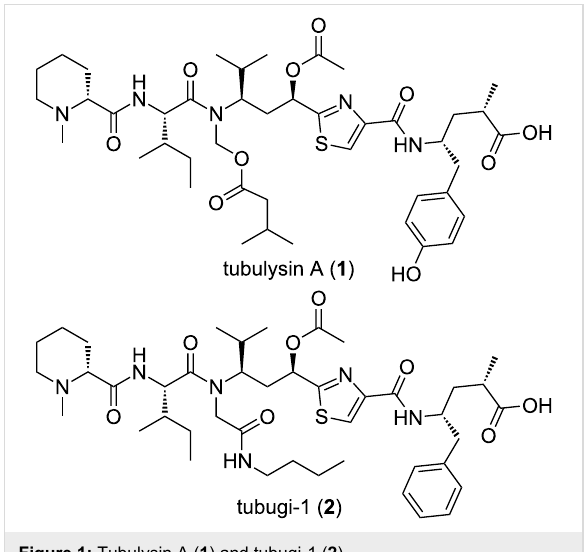
Figure 1: Tubulysin A ( 1 ) and tubugi-1 ( 2 ).